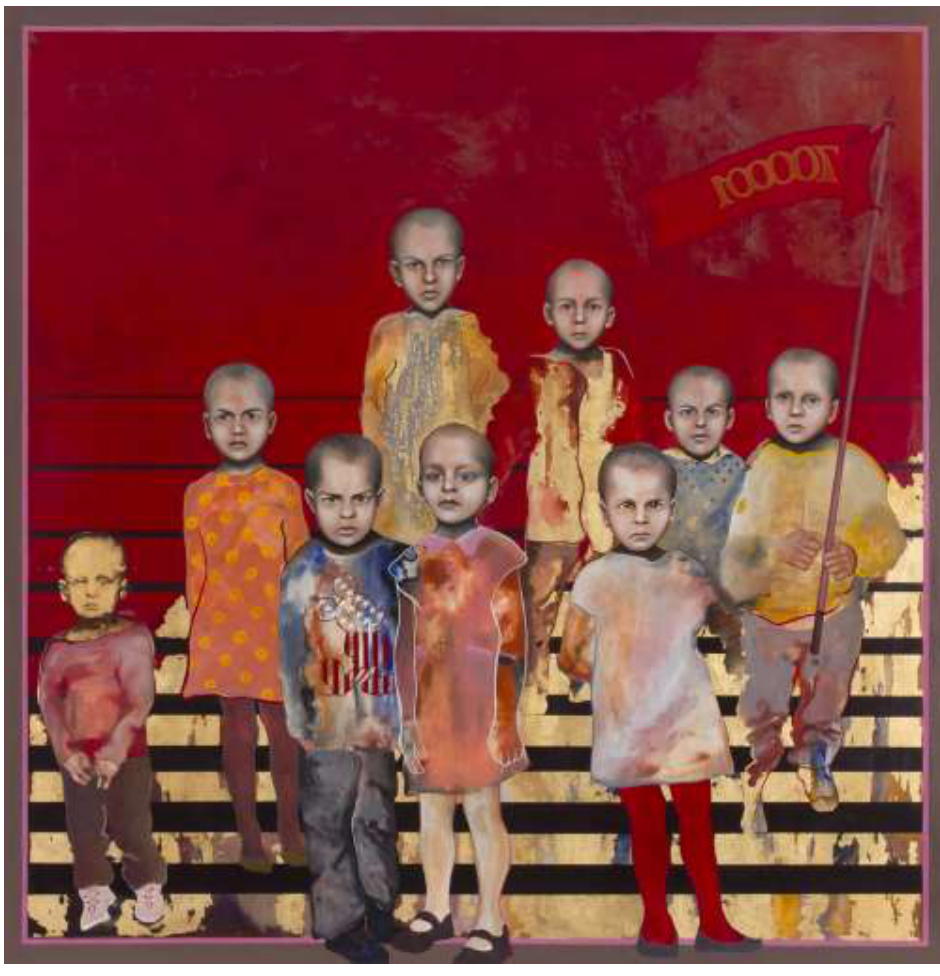
Julia Lambright, 700,000 in One , 2014, egg tempera and gold leaf on panel, 36.5 x 36 x 0.5